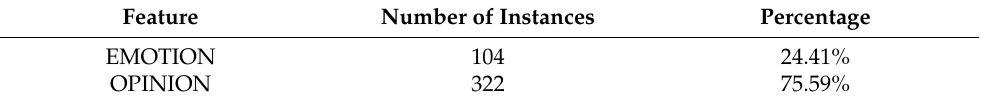
Table 1. EMOTION and OPINION features in the data set (total number of annotated items N =